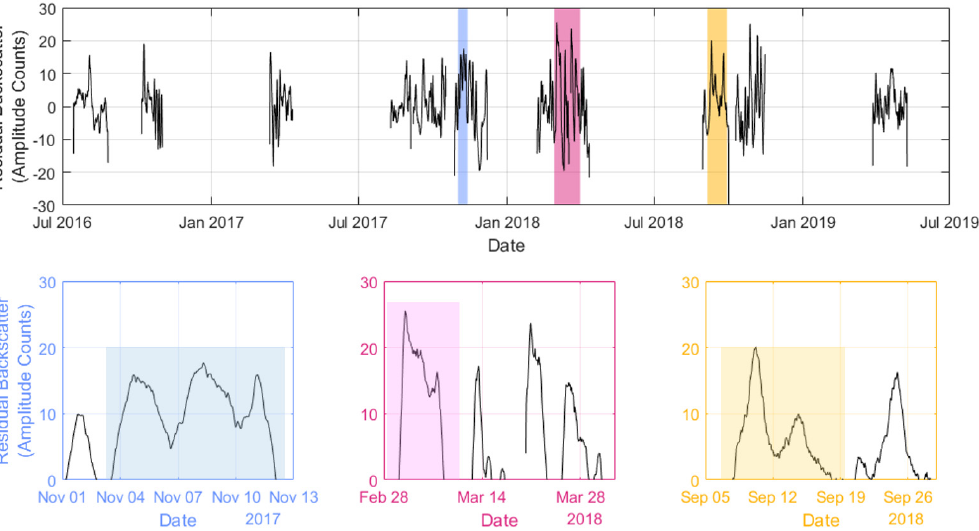
Figure 10. Residual backscatter values from all of the available deployments ( top ). The values here are an example from 0.3 m off of the seabed, while the analysis included all of the bins of the water column. The cluster examples include Sunny-Wind-Sunny (blue), Storm-Wind-Sunny-Storm (cyan), and Sunny-Wind-Sunny (orange).